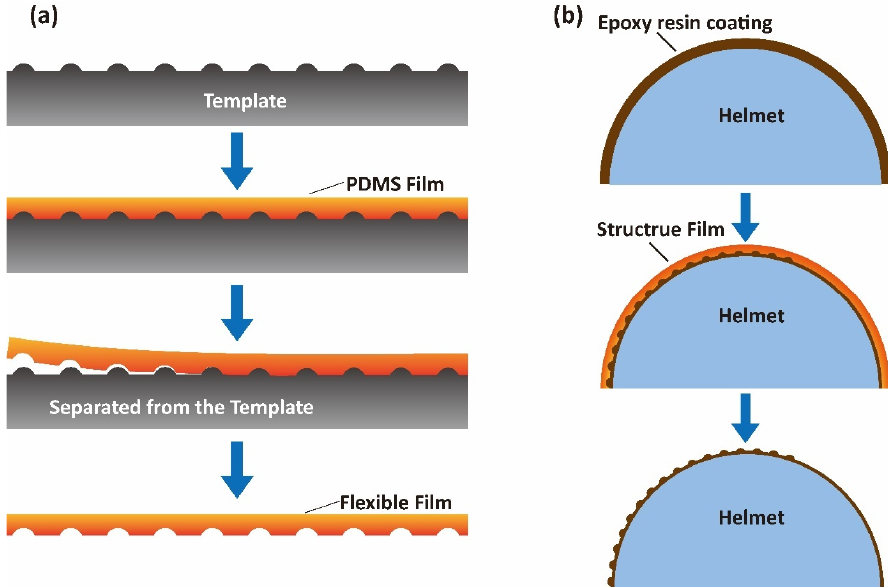
Figure 8. Schematic of fabrication method of surface structure on the helmet surface. ( a ) The fabrication of flexible film with structure; ( b ) the process of printing on the helmet surface.